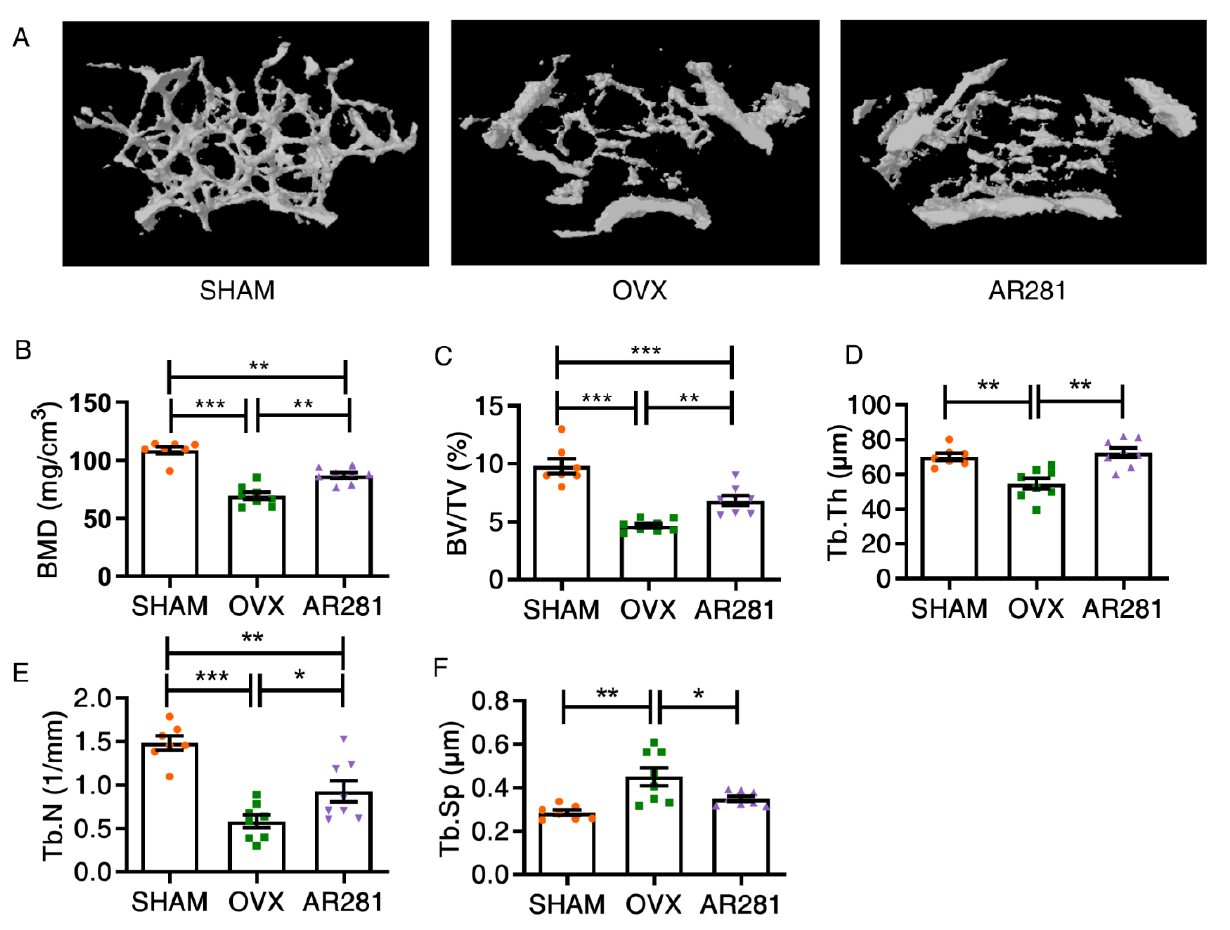
Figure 1. The effects of L. brevis AR281 on bone quality: ( A ) three-dimensional images of distal femur; ( B ) BMD; ( C ) BV/TV; ( D ) Tb.Th; ( E ) Tb.N; ( F ) Tb.Sp. Data are shown as mean ± SEM ( n = 8 per group, except n = 7 in the SHAM group) and are normally distributed. * p < 0.05, ** p < 0.01,